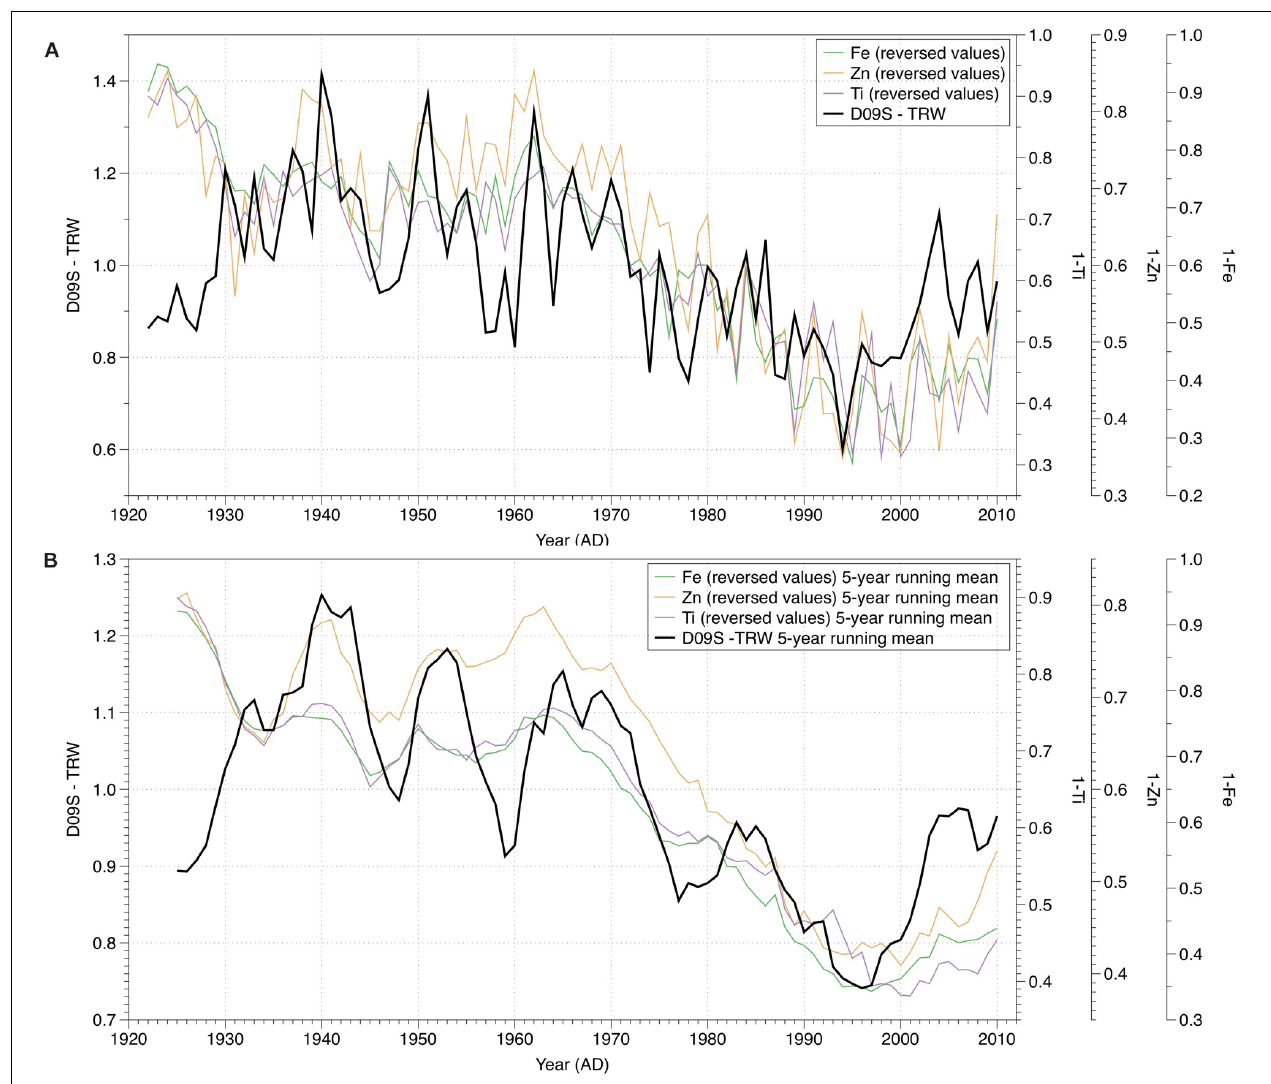
FIGURE 11 | Reversed values of Fe, Zn, and Ti compared with the tree-ring width indices (site D09S): (A) yearly values; (B) values smoothed with 5-year running mean.